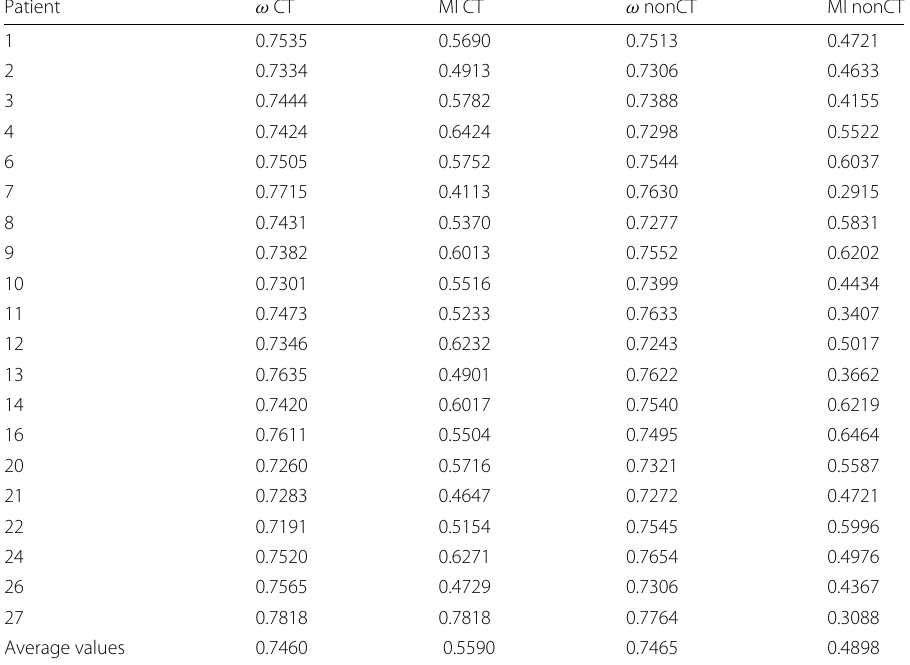
Table 2 Average value of the average edge overlat and mutual interaction for cross talks and non cross talks events